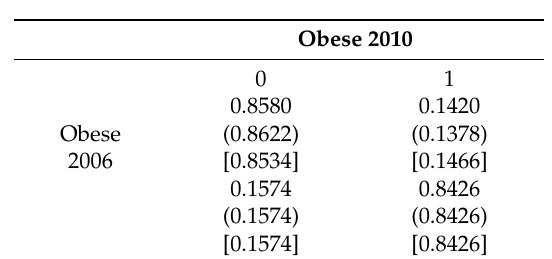
Table 1. Transition probabilities: young people (aged 15–24) (2006 to